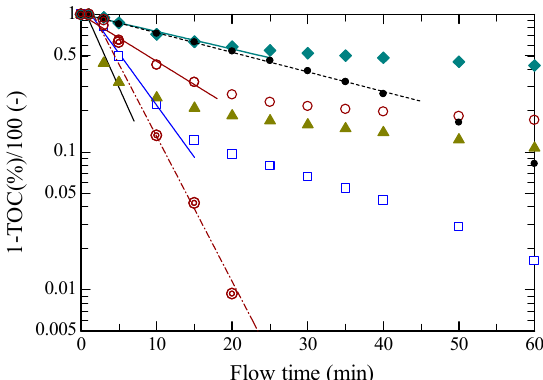
Figure 2. Dissolution rates in terms of TOC yield for regenerated solid filter paper: dissolved with various ILs or BEDC, precipitated, washed and then dried, together with original filter paper, all hydrolyzed in water at 533 K and 5.0 MPa for flow time up to 60 min in a semi-batch reactor. The key is the same as that in Figure 1.